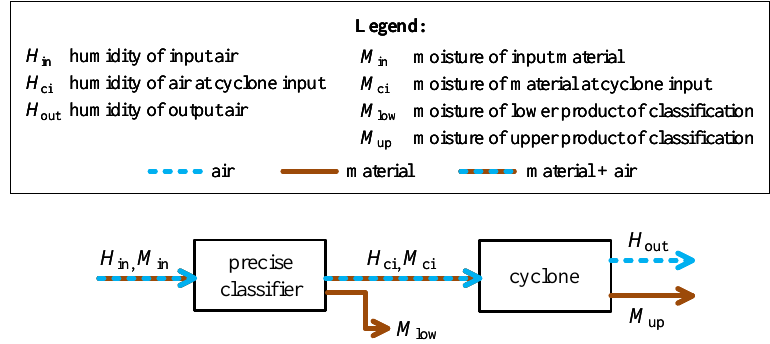
Figure 2. Moisture model (block diagram) of the classification subsystem.